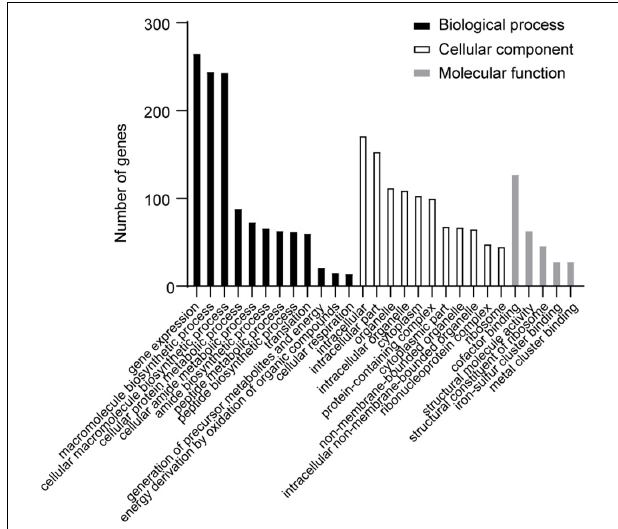
FIGURE 4 | The most enriched 30 GO terms of desiccation C . sakazakii G4023. Twelve terms belong to biological process; eleven terms belong to cellular component, and five terms belong to molecular